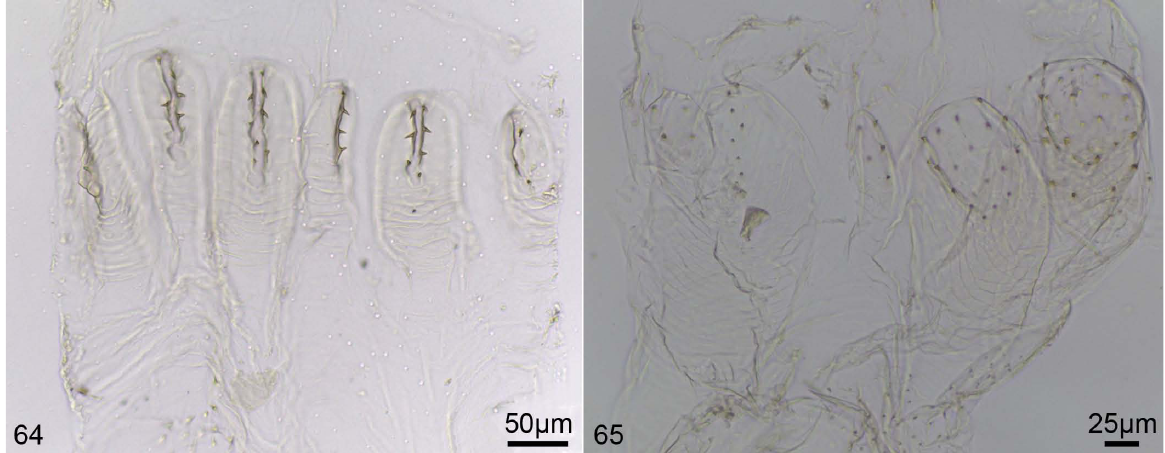
Figs 64–65. Enteric valve armature of: 64- Cavitermes tuberosus ; 65- Dihoplotermes inusitatus .